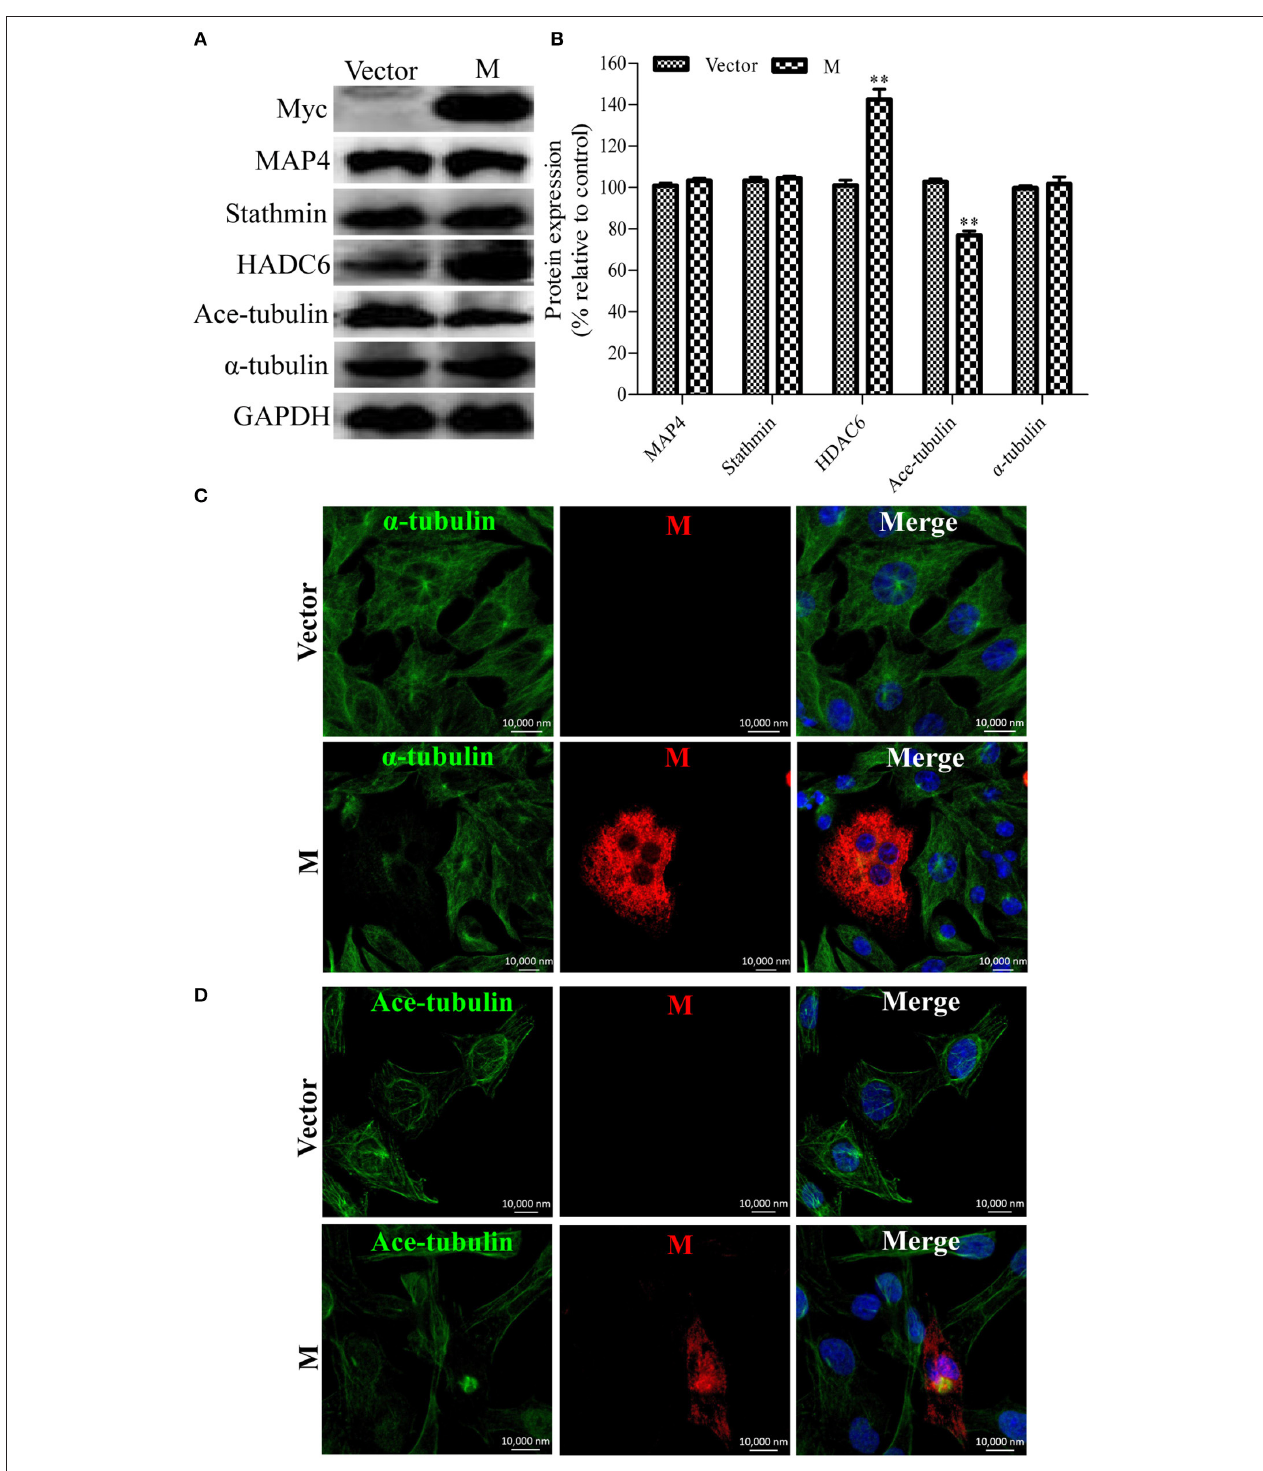
FIGURE 5 | Expression of the viral M protein alone induces microtubule depolymerization. (A) N2a cells were transfected with p-CMV-Myc-M or the pCMV-myc empty vector (control) for 36 h, and then subjected to Western blotting to determine the expression of MAP4, Stathmin, HDAC6, ace-tubulin, α -tubulin, and GAPDH (loading control). (B) The relative expression levels of MAP4, stathmin, HDAC6, ace-tubulin, α -tubulin were calculated by normalizing to that of GAPDH. (C,D) The distribution of the viral M protein (red), microtubule cytoskeleton (green), or acetylated microtubules (green) in N2a cells transfected with p-CMV-Myc-M or the pCMV-myc empty vector. Nuclei (Nuc) were stained with DAPI (blue). Scale bars, 10,000 nm. Data are represented as the means ± SD ( n = 3; **represents P < 0.01).